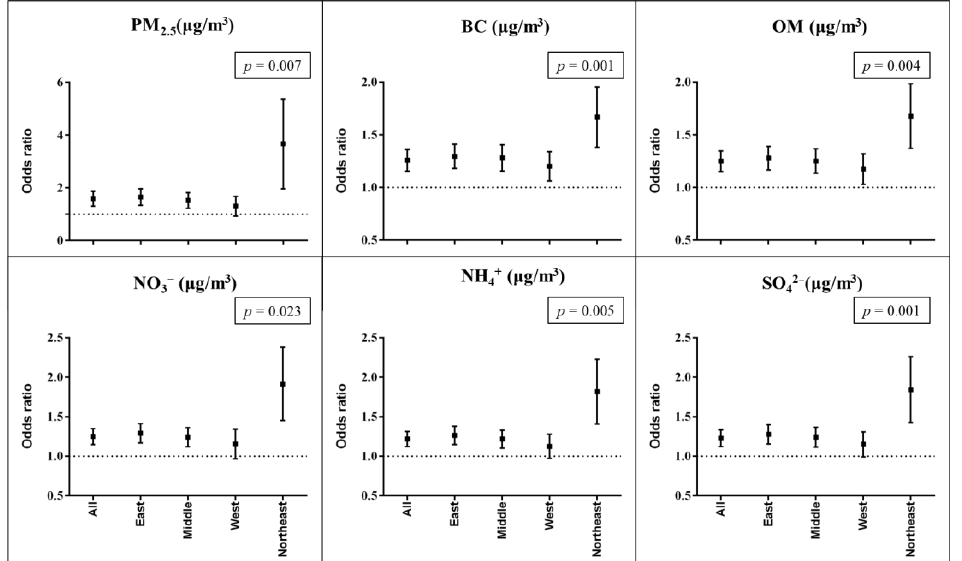
Figure 1. The association of metabolic syndrome (MetS) with an IQR incremental change in 1-year average PM 2.5 and its constitution, stratified by different regions. The bars show main effect estimates and 95% confidence intervals. The model was adjusted for age, sex, urbanicity, educational level, marriage status, smoking, drinking, cooking fuel type, heating fuel type, and physical activity. Abbreviations: BC: Black Carbon; NH 4 + : Ammonium; NO 3 − : Nitrate; OM: organic matter; SO 4 2 − : Sulfate. p value refers to the difference of the estimations between different